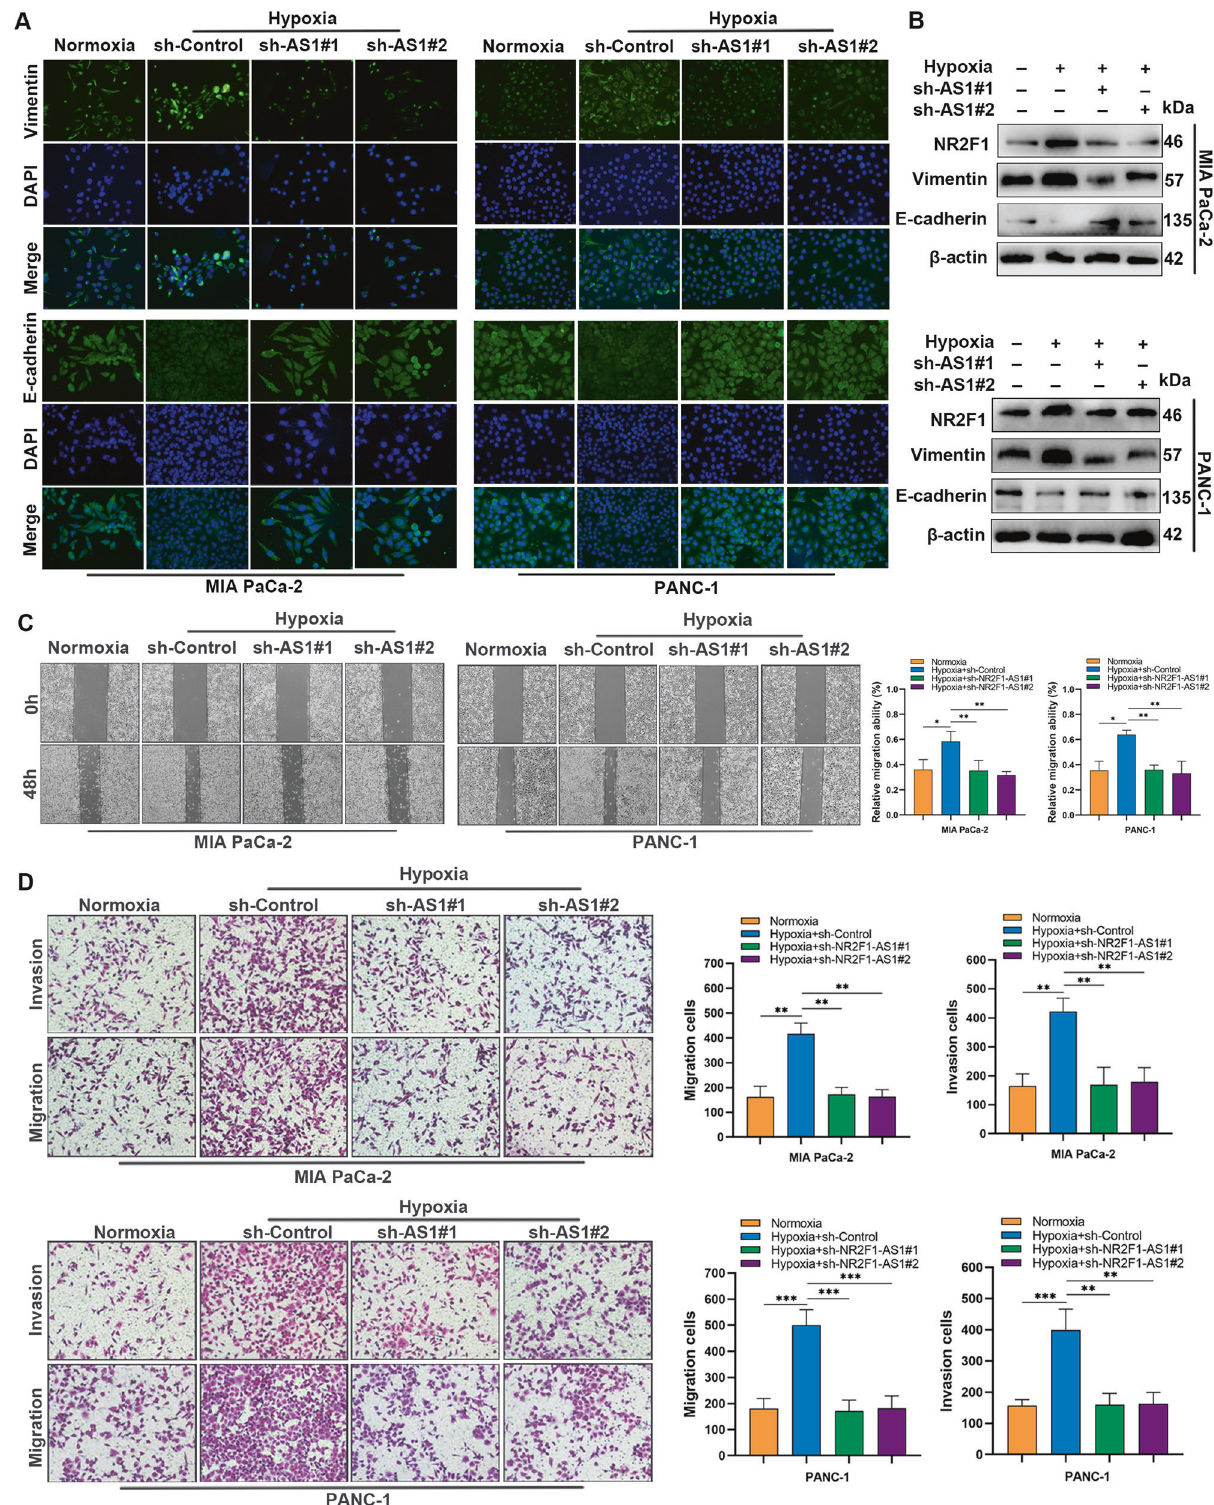
Fig. 8 NR2F1-AS1 plays an important role in the hypoxia-induced migration and invasion of PC cells. A IF staining of epithelial-to- mesenchymal transition markers in the indicated cells; scale bar = 100 μ m. B Western blot analysis of NR2F1, Vimentin, and E-cadherin expression in the indicated MIA PaCa-2 and PANC-1 cells. C Wound-healing assays were used to detect the migration ability of the indicated MIA PaCa-2 and PANC-1 cells. D Transwell assays were used to show the migration and invasion abilities of the indicated cells. For C and D , scale bar = 200 μ m. Data are expressed as mean ± SD. All experiments were repeated three times independently. * P < 0.05, ** P < 0.01, *** P < 0.001.